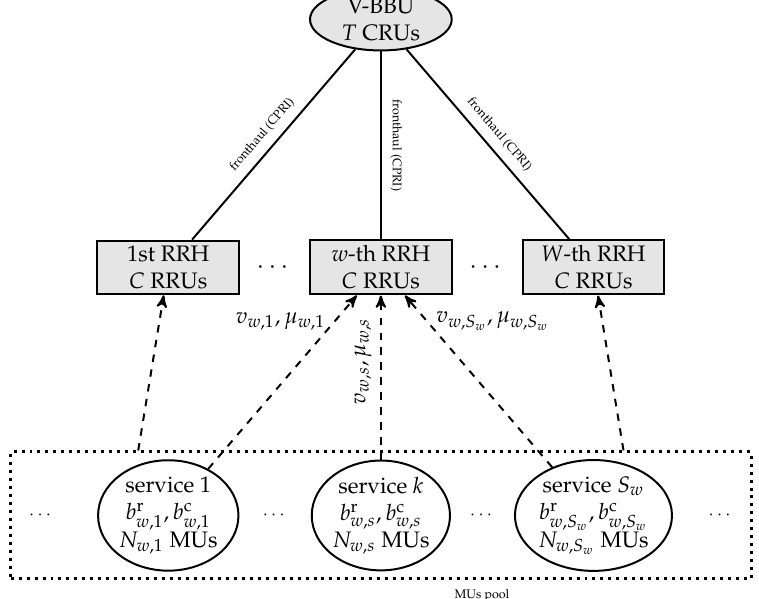
Figure 1. The f-MC-SC model.